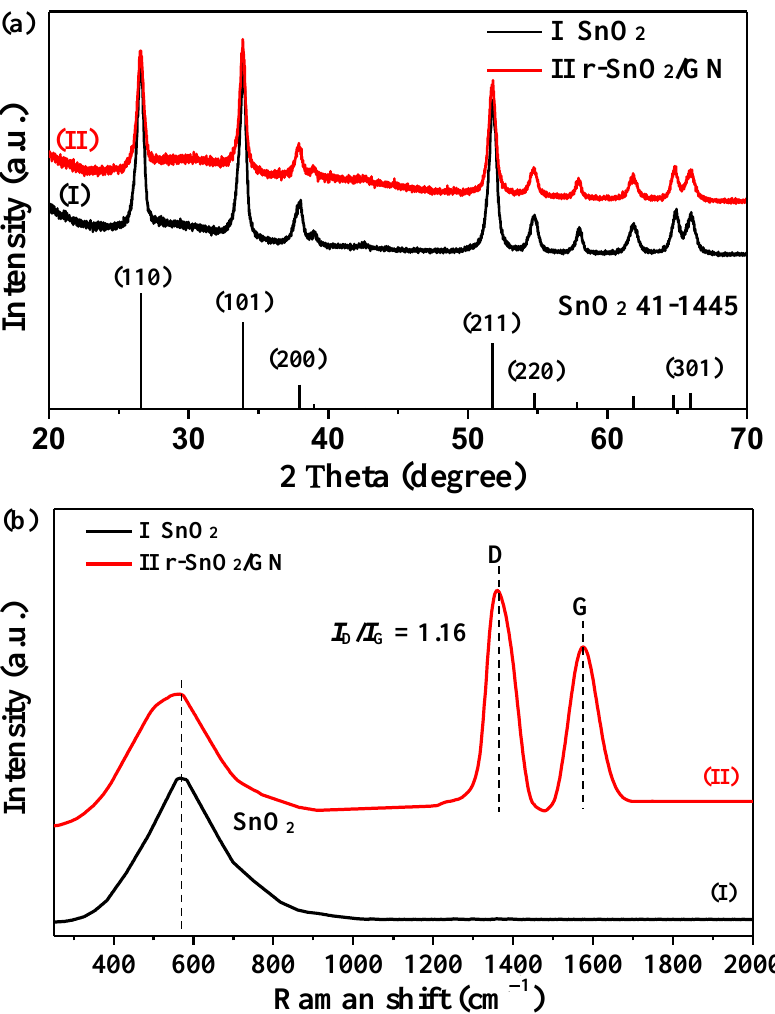
Figure 1. ( a ) XRD patterns of two samples SnO 2 (I) and r-SnO 2 /GN (II); ( b ) Raman spectra of two samples SnO 2 (I) and r-SnO 2 /GN (II).